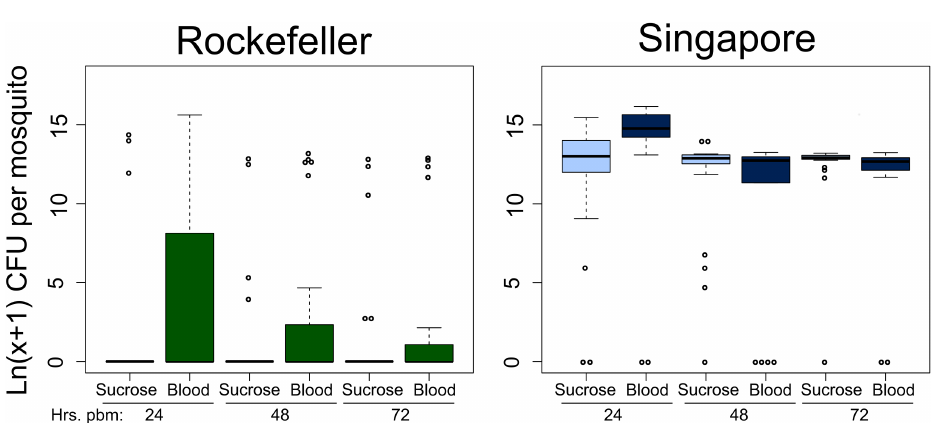
Fig 2. Rockefeller female midguts have lower bacterial loads than Singapore females at multiple time points post blood feeding. We reared female A . aegypti from Rockefeller and Singaporestrains in parallel and mixed the breedingwater betweenstrains three times during larval/pupal development. We maintained adults on 3% sucrose until 5 days post eclosion,at which point a subset of the femaleswere givena sterile bloodmeal. At 24, 48 and 72 hours post bloodfeeding,we externallysterilized sugar and bloodfed females from each strain with 70% EtOH, dissectedmidgutsfrom each strain/feedingtreatment, homogenized individualmidgutsin 1X PBS using a sterile pestleand dilutedthe homogenate 1:100 and 1:10 4 using additional 1X PBS. We spread50ulof each dilutionas wellas undilutedhomogenate on LB agar plates, allowedthe platesto grow for 48 hours at room temperatureand then countedthe total CFUs on eachplate. We performed a zero-inflateddata analysisto test the effect of strain, feedingstatus and time post bloodfeeding,as well as all pairwiseinteractionsand a three-wayinteraction betweenfactors. We performedstepwise backwardsselection of modelterms using likelihoodratio tests to assess the significanceof each droppedterm. For count data, strain was a significant predictorof bacterial load(p = 0.0237)and we also detecteda significantinteraction betweenfeedingstatus and time post bloodfeeding(p = 0.0060).For presence/absencedata, we detecteda significant interactionbetweenstrain and feeding status (p = 0.0390).Time post bloodfeedingwas not a significant predictorfor presence/absencedata. Data were collectedover three experimental replicatesand total samplesizes are as follows:n rock.sug.24 = 23; n rock.sug.48 = 23; n rock.sug.72 = 21; n sing.sug.24 = 24; n sing.sug.48 = 24;